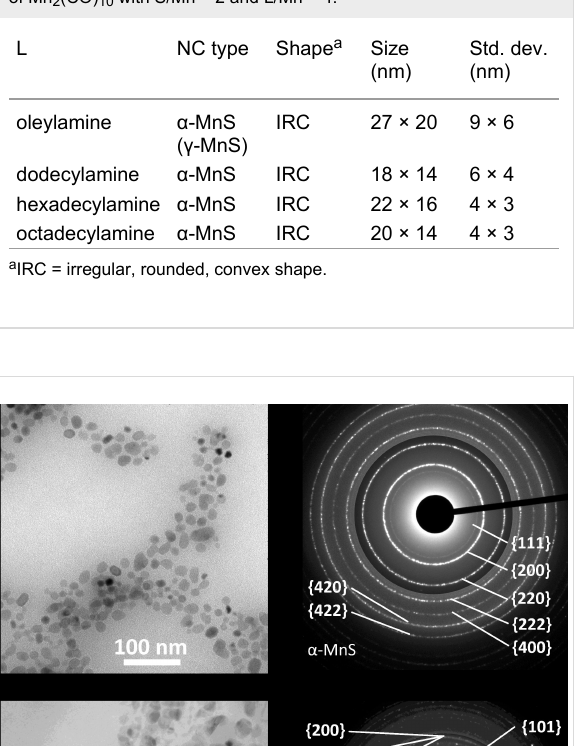
Table 2: Properties of NCs synthesized by the thermal decomposition of Mn 2 (CO) 10 with S/Mn = 2 and L/Mn = 4.